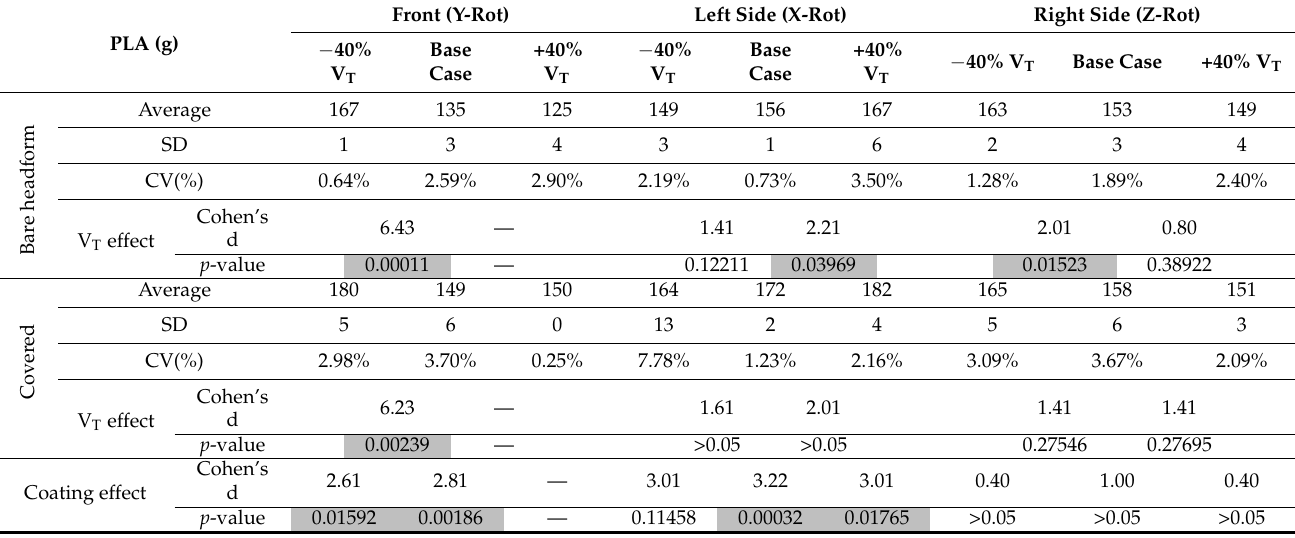
Table 3. Averages, standard deviation (SD), coefficient of variation (CV) and post-hoc results for PLA. p -values < 0.05 portrayed as shaded